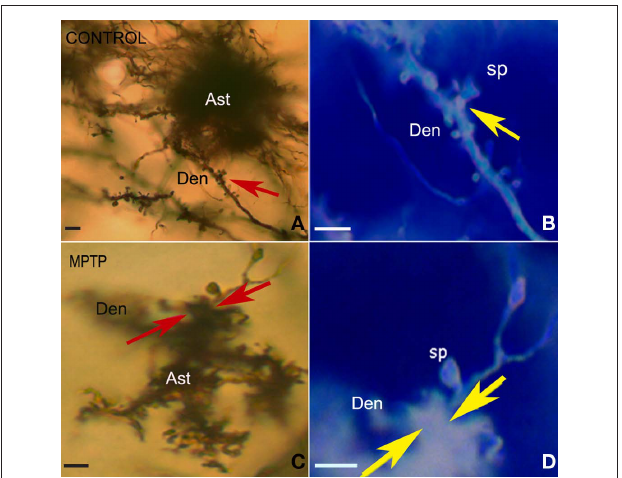
Figure 2 | Light micrographs of silver-impregnated protoplasmic astrocytes in the striatum of control (A,B) and MPTP-treated (C,D) monkeys. (A,C) Protoplasmic astrocytes with numerous fine processes reaching out from the soma (A) or from the 3–5 main stems (B) , each of which being highly ramified to generate numerous leaflet-like processes. (B,D) High magnification images of a mushroom-shaped spine in a control (B) and a MPTP-treated (D) animal that showed a larger extention of astrocyte-like processes juxtaposition with dendritic spines after MPTP treatment (arrows). These micrographs (B,D) have been color inverted using Adobe Photoshop, version 7.0. Abbreviations: Ast, astrocytes; Den, dendrite; sp, dendritic spine. Scale bars: